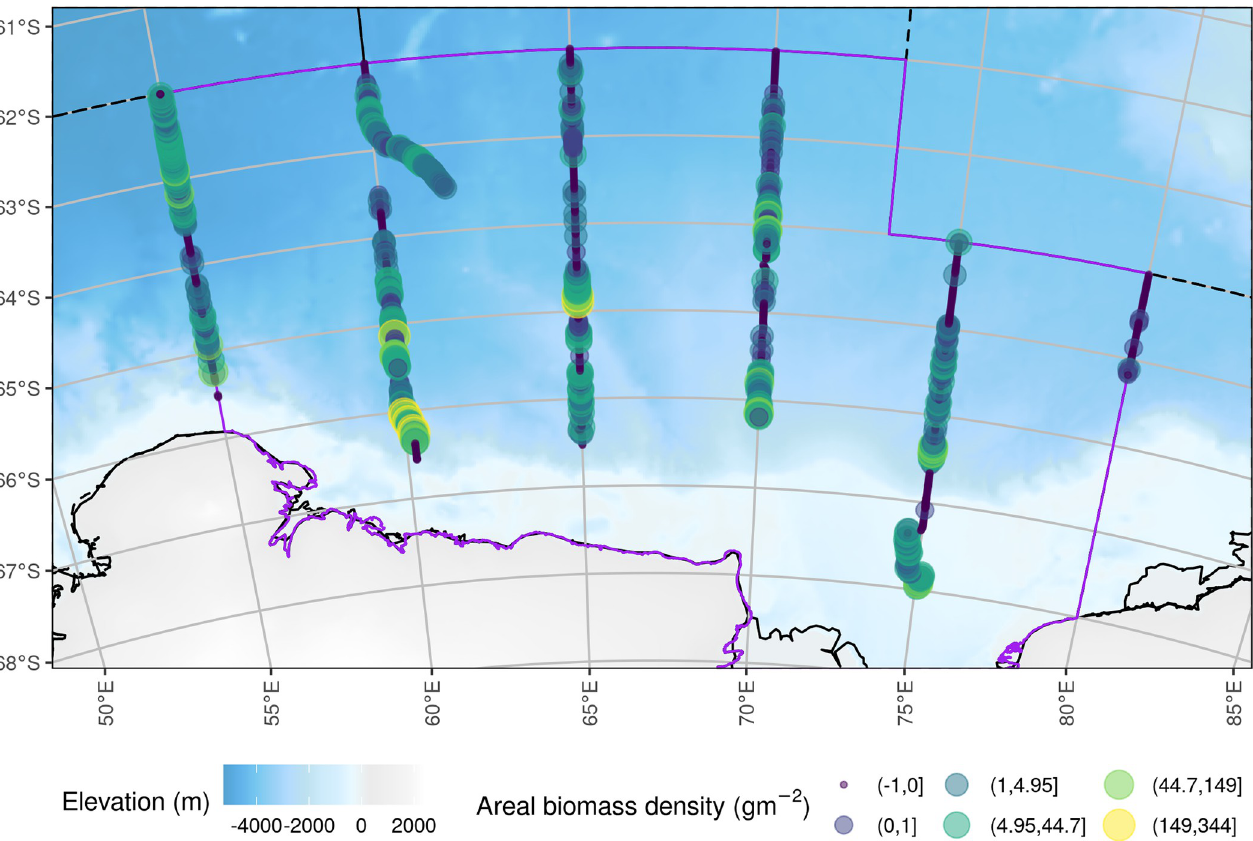
Fig 6. Krill areal biomass density per one nautical mile integration interval to a 250 m water depth. Circle colour is related to a category of krill areal biomass density denoted by the intervals in the legend. The eastern sector of CCAMLR Division 58.4.2 covered by the survey is shown as a grey shaded area with a purple boundary. The background bathymetry grid is from The GEBCO_2014 Grid, version 20150318, www.gebco.net.